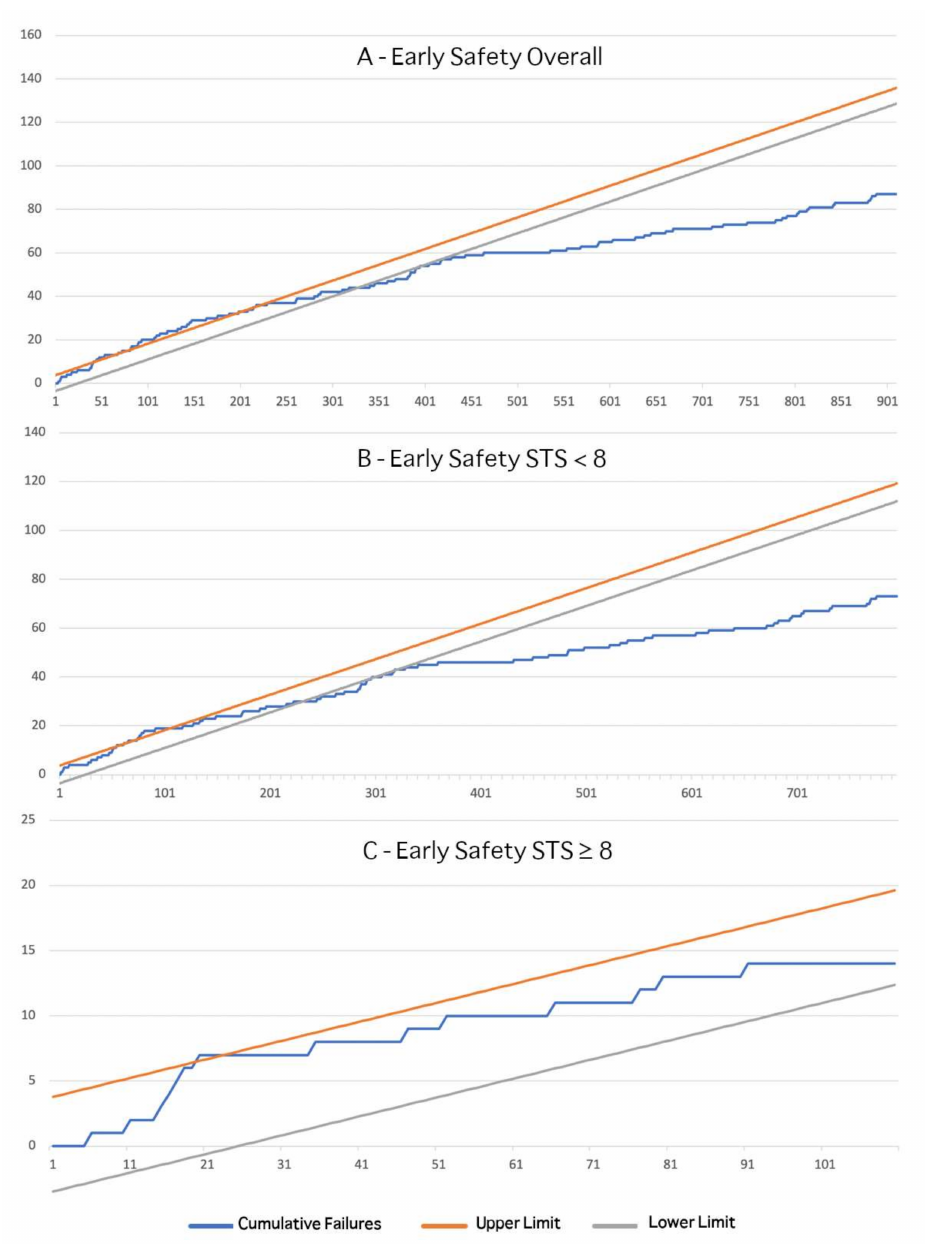
Figure 3. CUSUM Analysis for early safety. Incremental line represents unadjusted cumulative sum of failures. Lower and upper limits are calculated upon acceptable and unacceptable failure rates of 10 and 20%, respectively. Observations above the upper limit indicate out of control pro- cedure, while observation below the lower limit suggest better-than-expected results (proficiency). CUSUM analyses are provided for the overall population ( A ), low-intermediate risk ( B ) and high-risk subgroups ( C